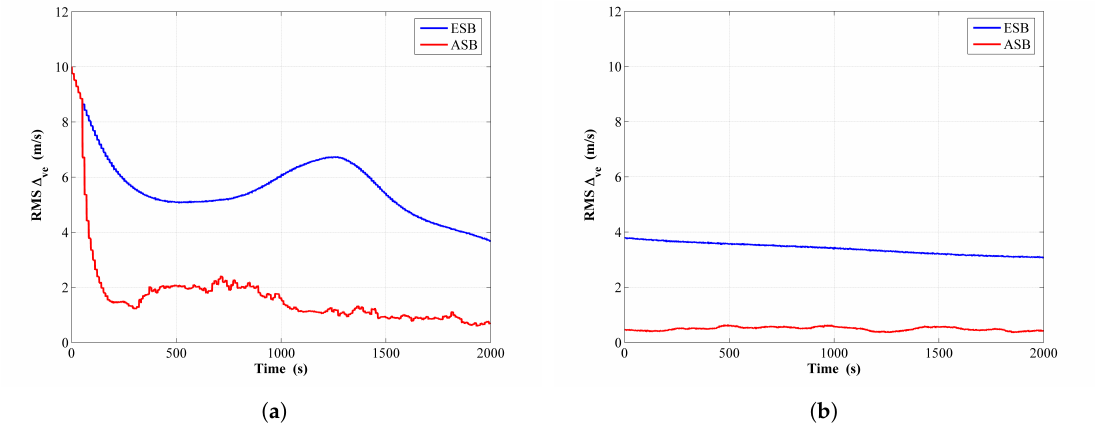
Figure 4. RMS of ESV estimated error by the ESB and the ASB algorithms using simulation data with unknown R k : ( a ) Filter; ( b ) RTS smoother.